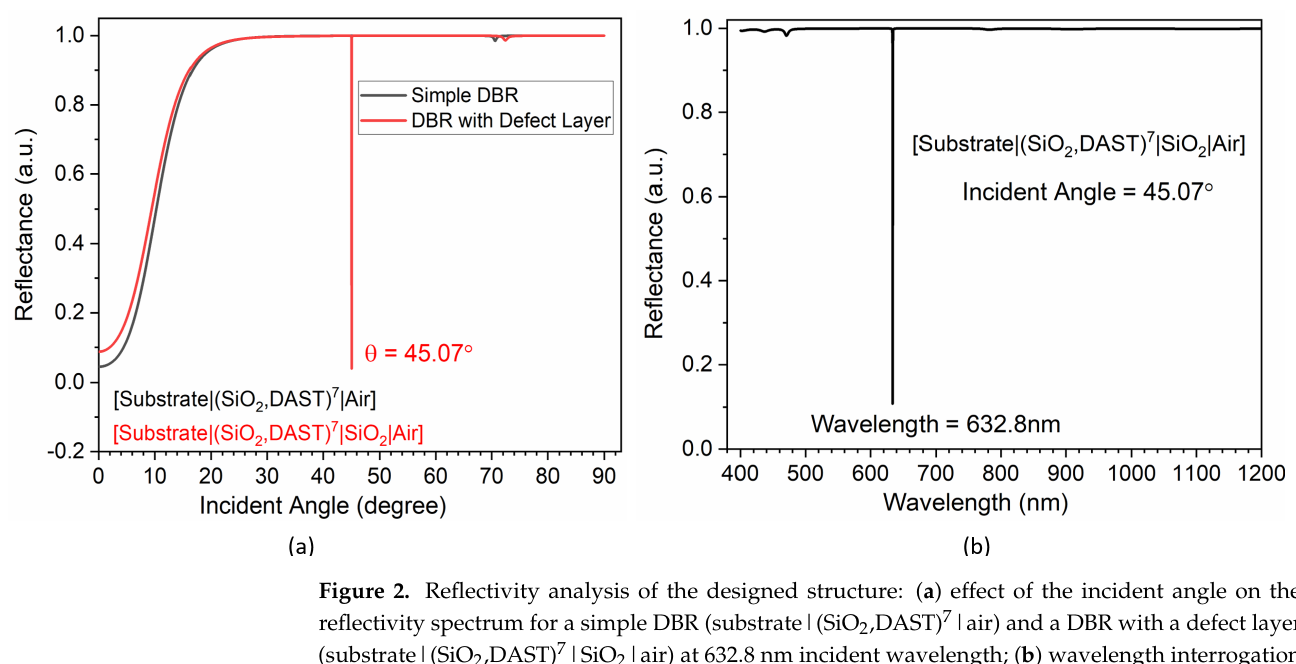
Figure 2. Reflectivity analysis of the designed structure: ( a ) effect of the incident angle on the reflectivity spectrum for a simple DBR (substrate|(SiO 2 ,DAST) 7 |air) and a DBR with a defect layer (substrate|(SiO 2 ,DAST) 7 |SiO 2 |air) at 632.8 nm incident wavelength; ( b ) wavelength interrogation